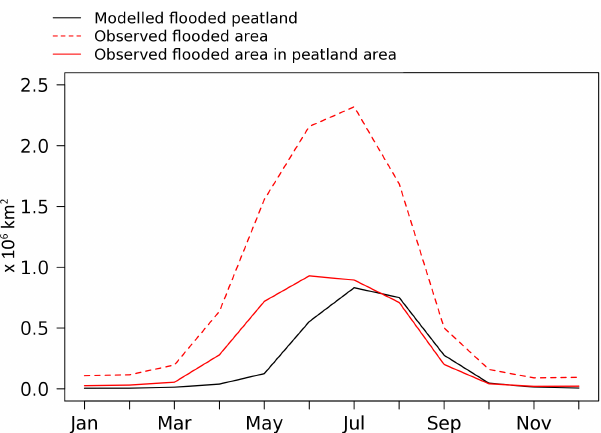
Figure 12. Mean seasonal cycle of flooded land areas of 0.5 ◦ grid cell for the 1993–2006 period from the modelled flooded peatland (black), observed flooded area above latitudes 45 ◦ N (dashed red line) and from observed flooded area located in grid cells with non- zero fraction of peatlands (red